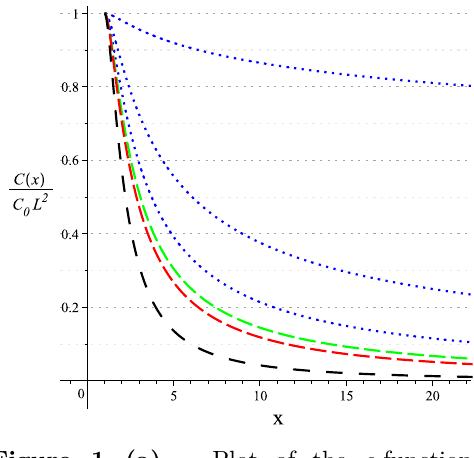
Figure 1 (b). Plot of the c -function in terms of the canonical radial coordinate r = η the same values of the ν